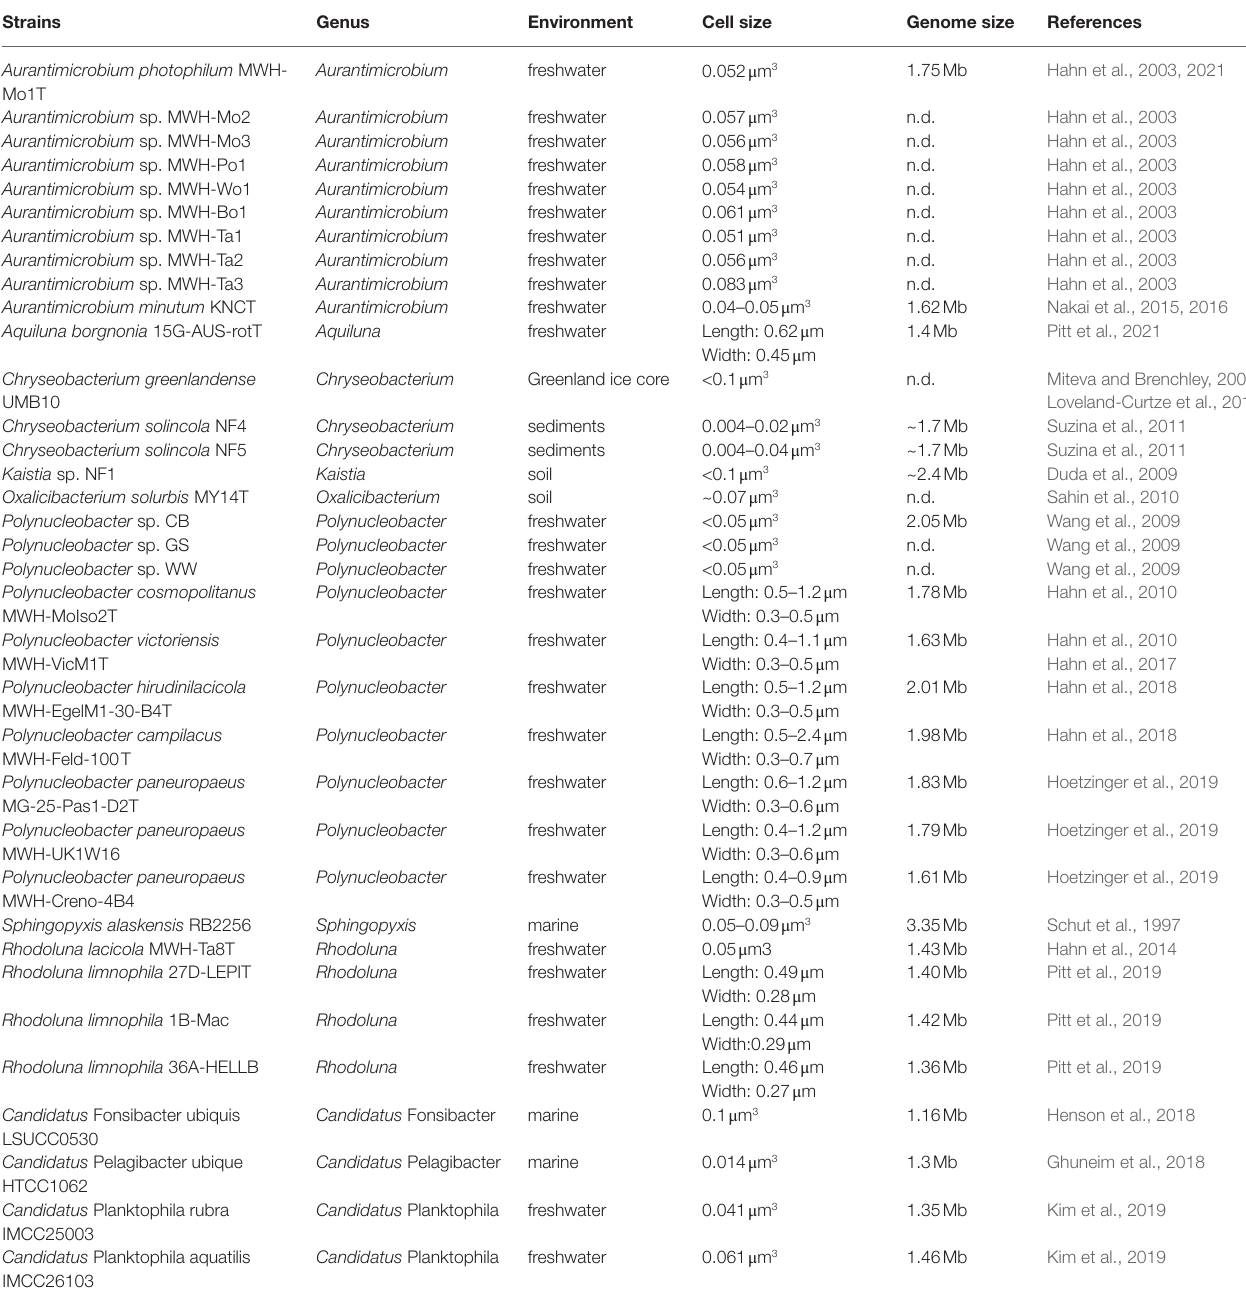
TABLE 2 | An overview of LNA bacteria and their candidates in the environments. Strains Genus